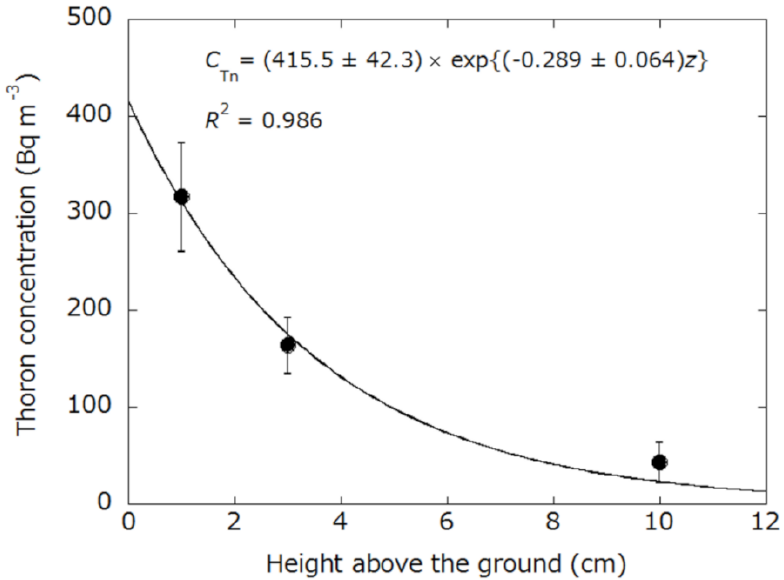
Figure 2. Example of the vertical distribution of thoron concentration inside the ventilated type accumulation chamber. The thoron concentration at ground level ( z = 0 cm) was determined to be 416 ± 42 Bq m − 3